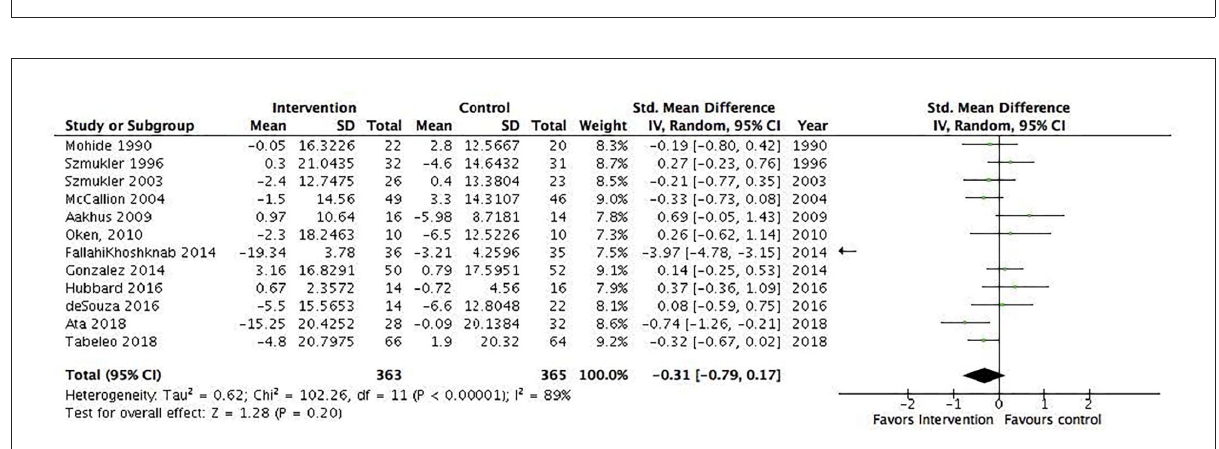
FIGURE9 Subgroup analysis of interventions that were non-manualized interventions, ≤ 8 weeks of duration, individual/group delivery format: All studies. Mean within-group changes and standardized mean